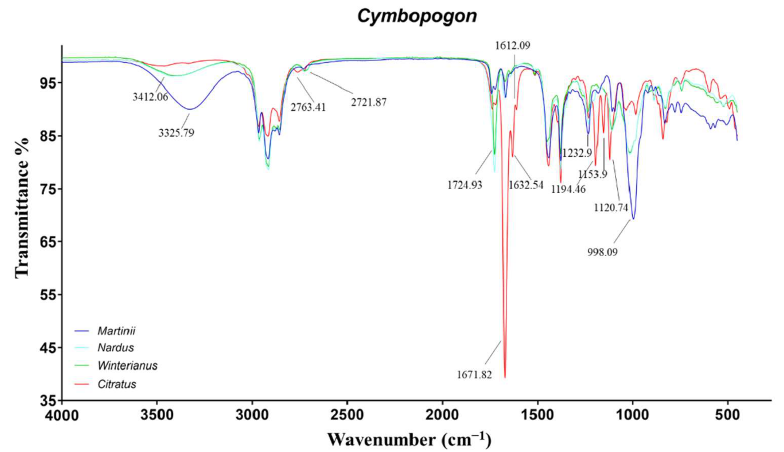
Figure 3. ATR-FTIR spectra of Cymbopogon martinii, Cymbopogon nardus, Cymbopogon winterianus, and Cymbopogon citratus.